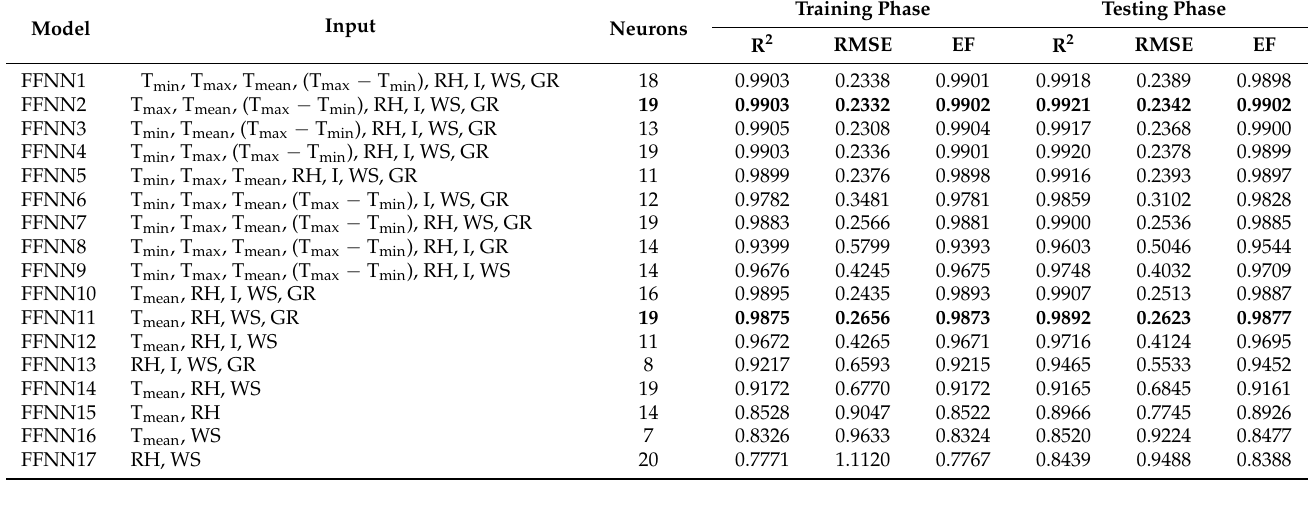
Table 4. Statistical criteria for an estimation of ET 0 using different input variables for FFNN. The bold part shows that this model is superior to others.